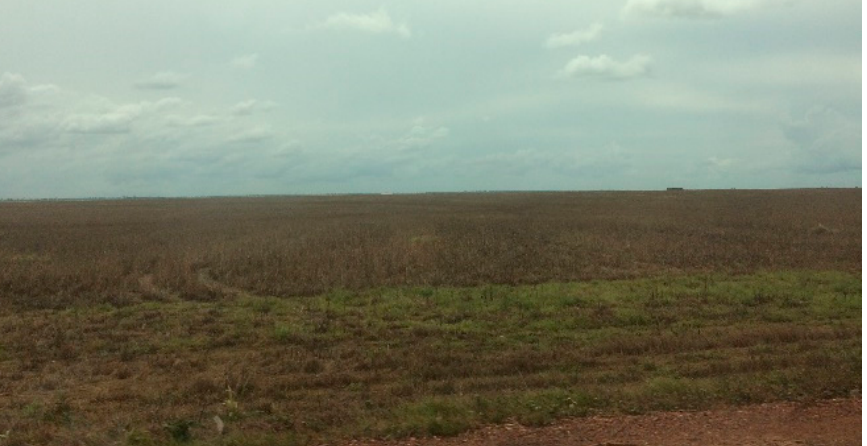
Figure 9. Landscape change: burnt areas destined for planting soybeans along the federal highway BR-153 in January 2021. Prepared by the authors.